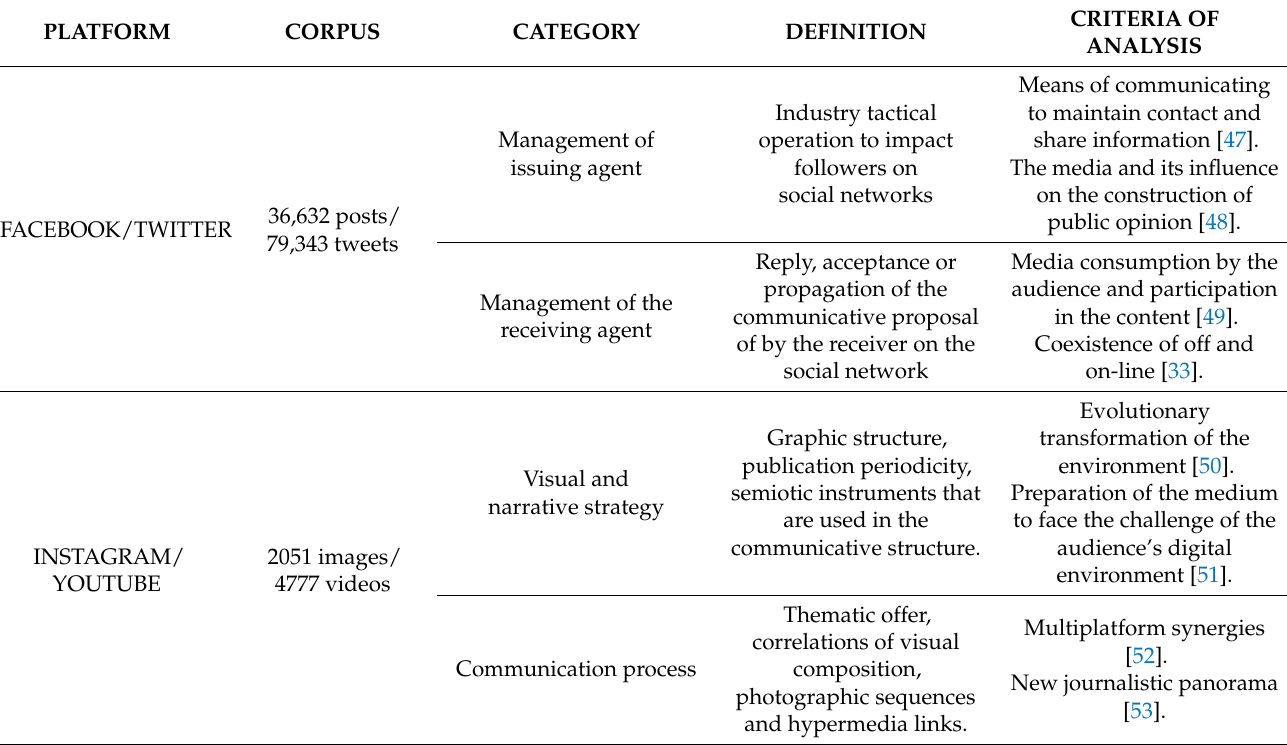
Table 3. Quantitative data analysis categories.